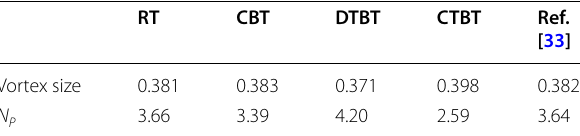
Table 4 Vortex size & power number for different agitator’s types of tanks with